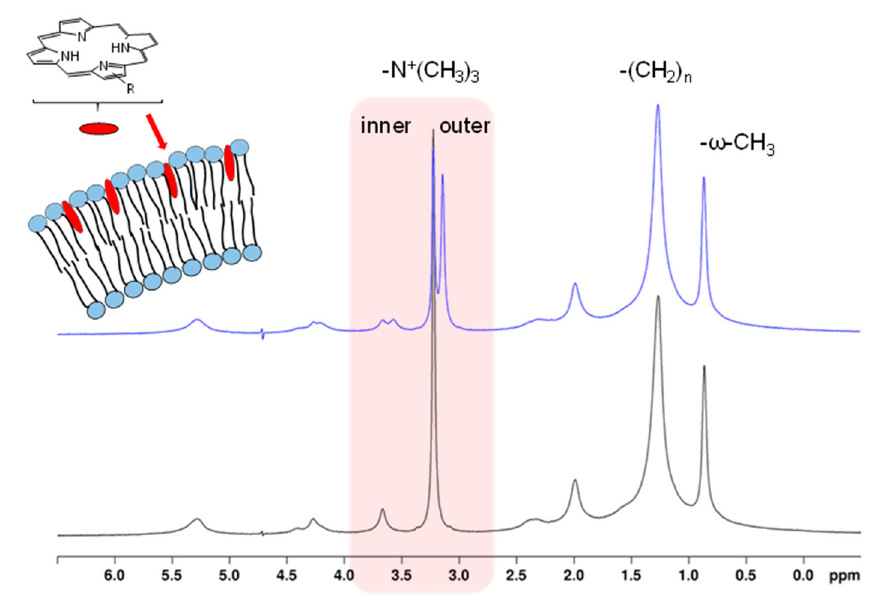
Figure 5. 1 H NMR spectrum (500 MHz) of DOPC SUVs in water before (bottom) and after (top) addition of a Ce6 derivative. The interaction of the chlorin with the DOPC bilayer induces a split of the DOPC choline resonances so that the outer and inner PL layers become distinguishable.